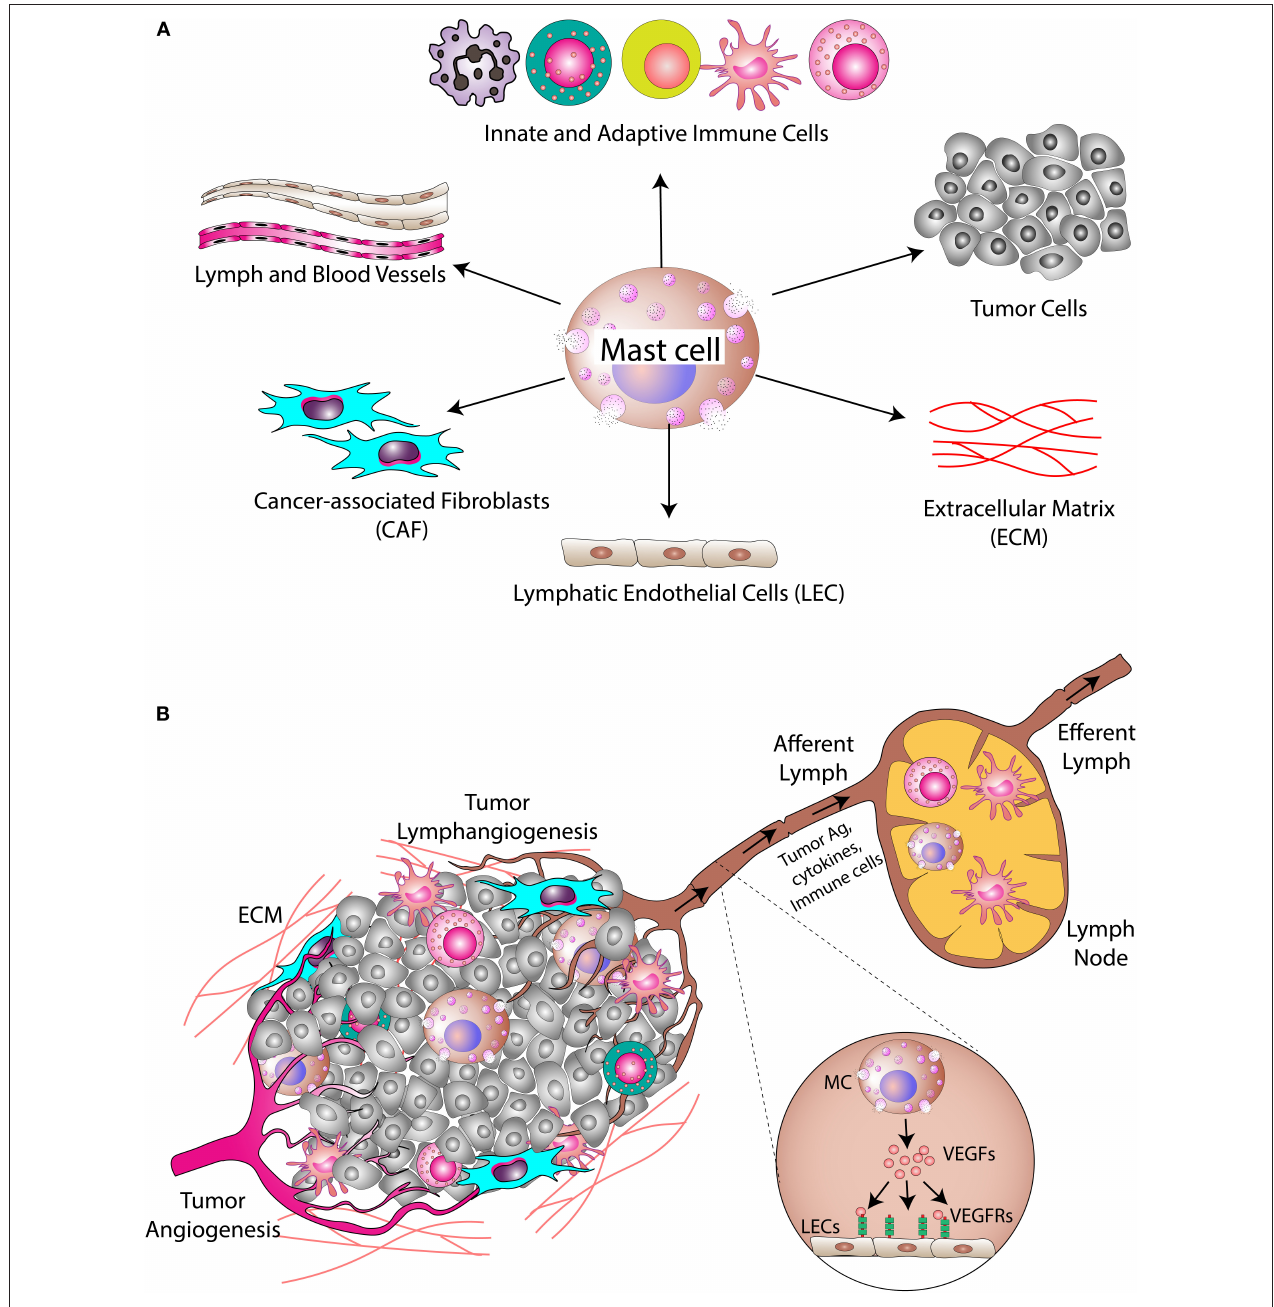
FIGURE 3 | Mast cells in the tumor microenvironment. (A) MCs secrete different cytokines/inflammatory mediators into the tumor microenvironment. These cytokines/inflammatory mediators modulate cellular and acellular components of the tumor. The cellular components include cancer cells, cancer-associated fibroblasts, and different types of immune cells, while the acellular component is mainly the extracellular matrix (ECM). (B) MCs also modulate angiogenesis and lymphangiogenesis in the tumor. Tumor necrosis factor-alpha (TNF α ) released by MCs induces migration of DCs into the draining lymph nodes where T cell activation takes place. MC-derived proteases induce modification of the ECM, which alters the microarchitecture leading to metastasis.